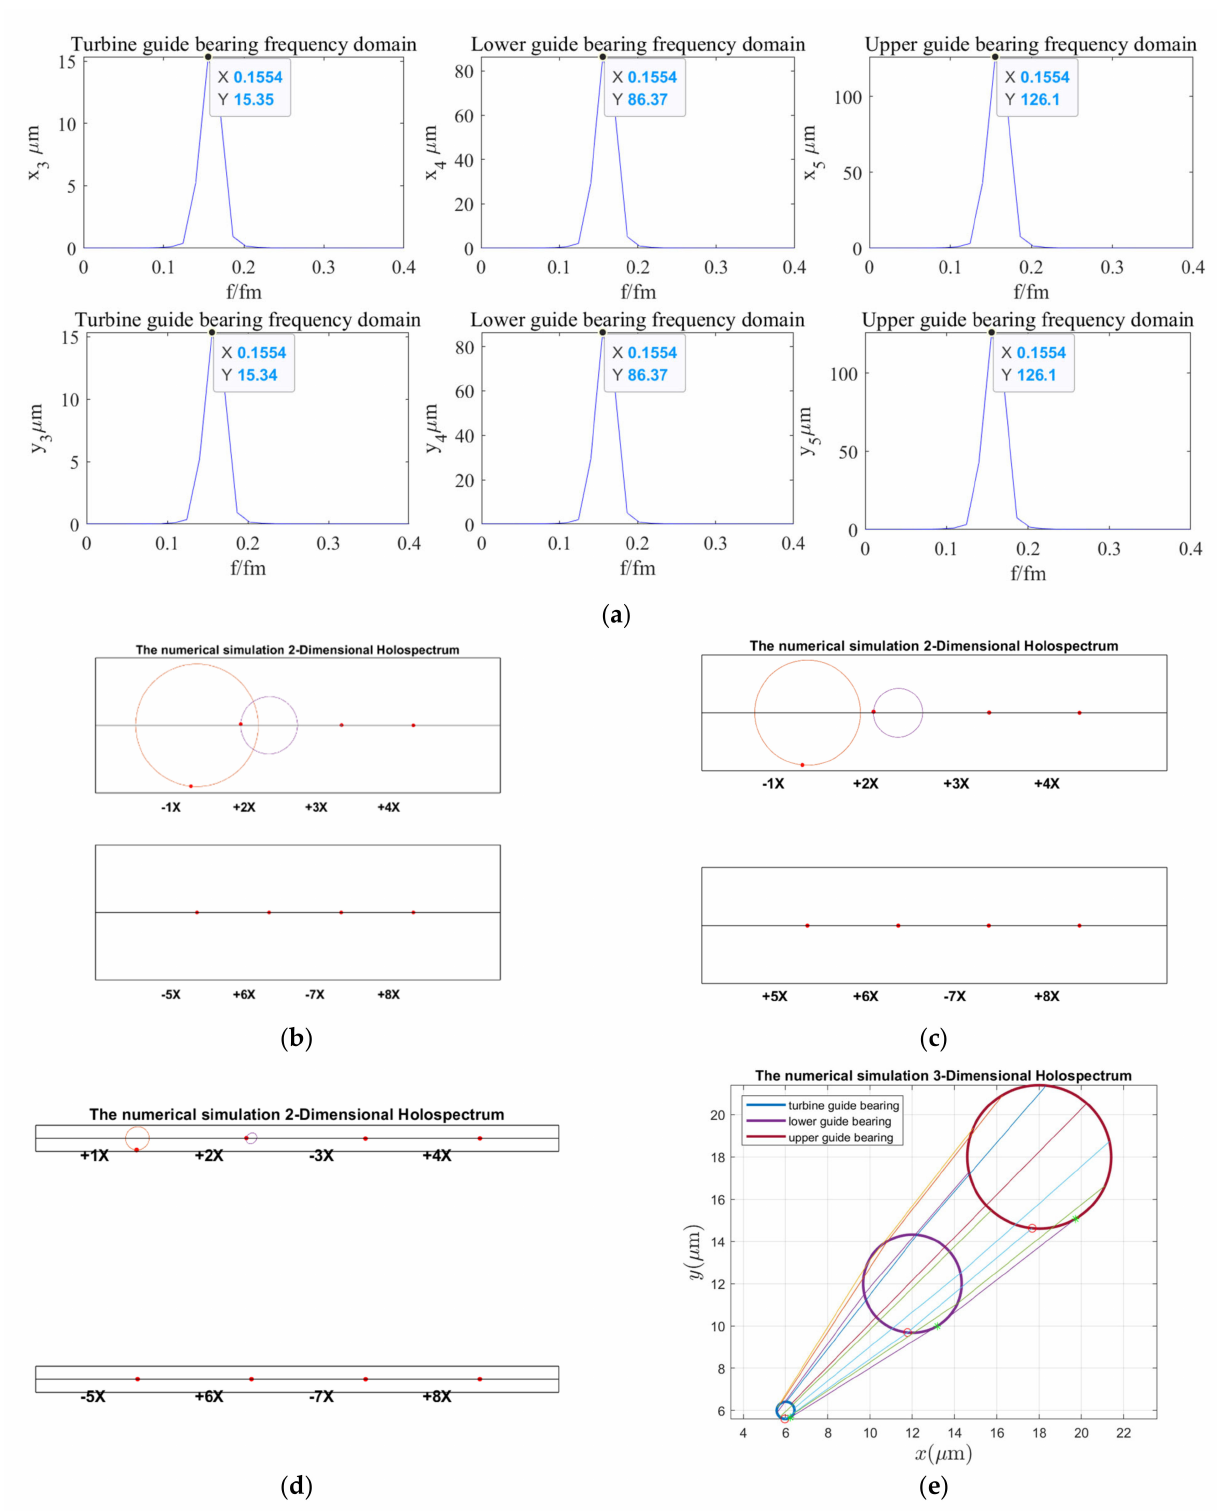
Figure 16. Holospectrum of shafting vibration of misaligned unbalance rotor, considering the oil film, RAW, and rub forces: ( a ) Shafting vibration spectrogram, ( b ) Upper guide bearing 2D holospectrum, ( c ) Lower guide bearing 2D holospectrum, ( d ) Hydro-turbine guide bearing 2D holospectrum, ( e ) One-fold frequency 3D